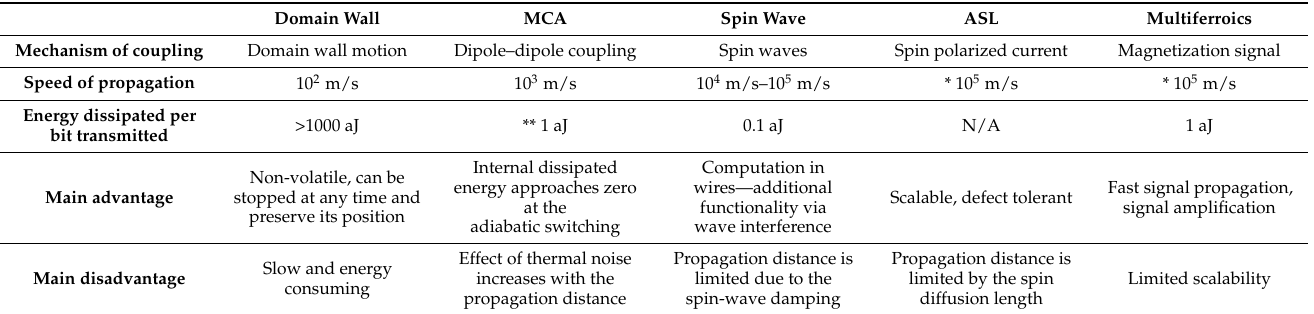
Table 1. The estimates on the main characteristics of different